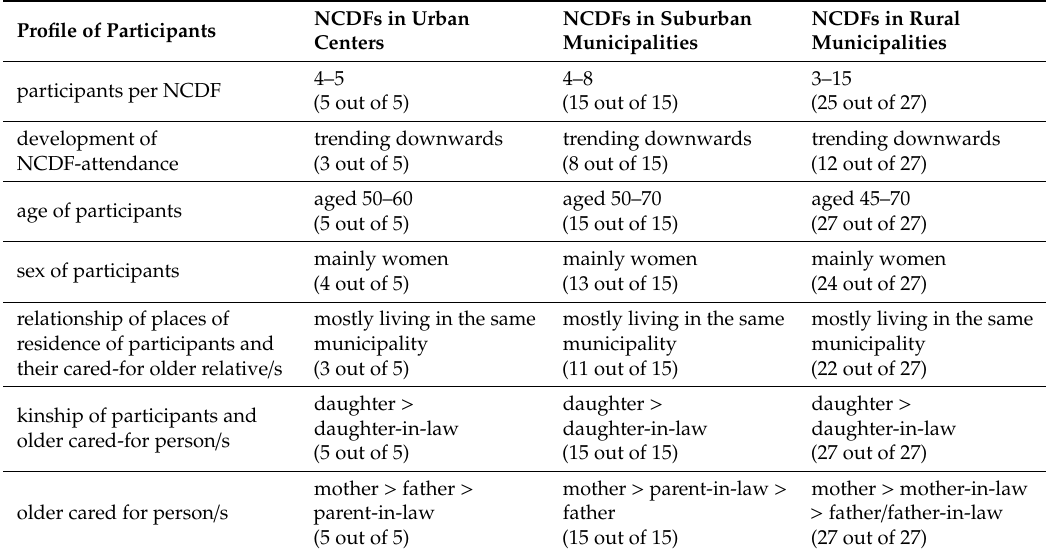
Table 5. Profile of NCDF-participants belonging to the second generation of caregiving